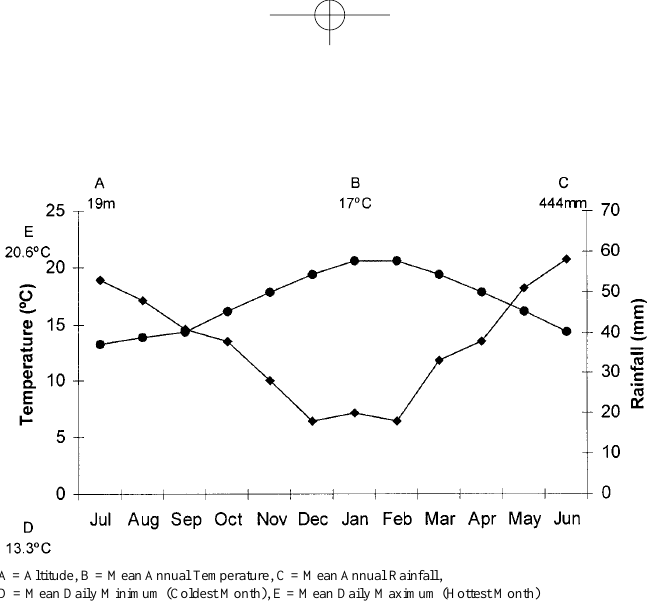
A= Altitude, B = Mean Annual Temperature, C = Mean Annual Rainfall, D = Mean Daily Minimum (Coldest Month), E = Mean Daily Maximum (Hottest Fig. 1. A Walter climatic diagram for Andrew’s Field and Tsaba-Tsaba Nature Reserve.